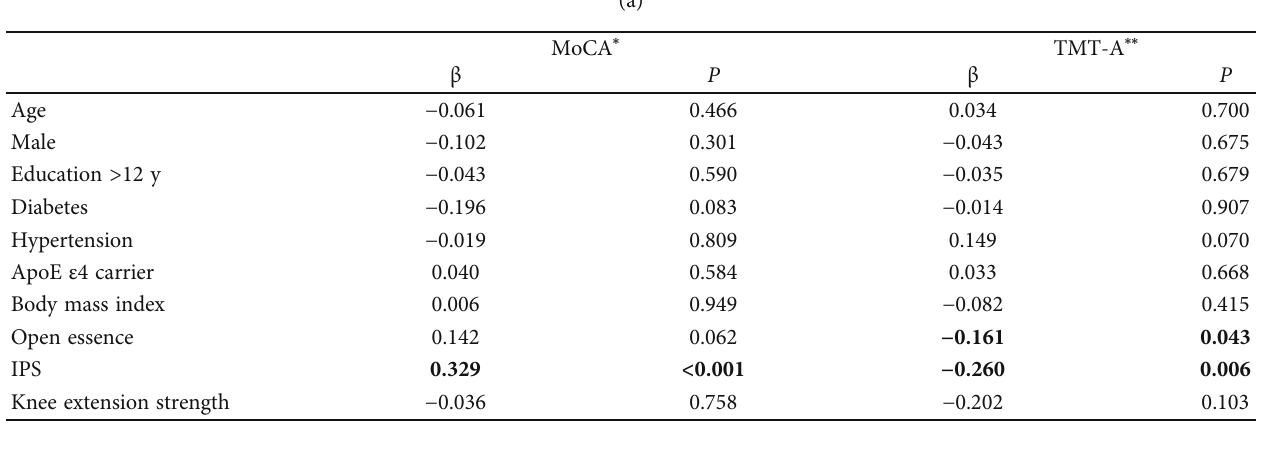
Table 6: Multiple linear regression analyses of cognitive functions in the entire participant